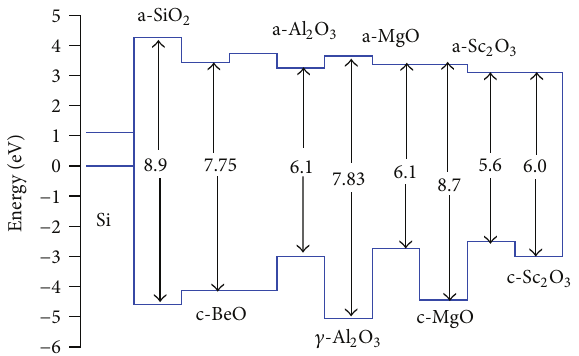
Figure 7: Schematic of band alignment at the interfaces of silicon with oxides of several light metals. The diagrams are shown for amorphous (a-) and crystalline cubic ( 𝛾 -, c-) phases. The origin of the energy scale is at the top of the silicon VB.